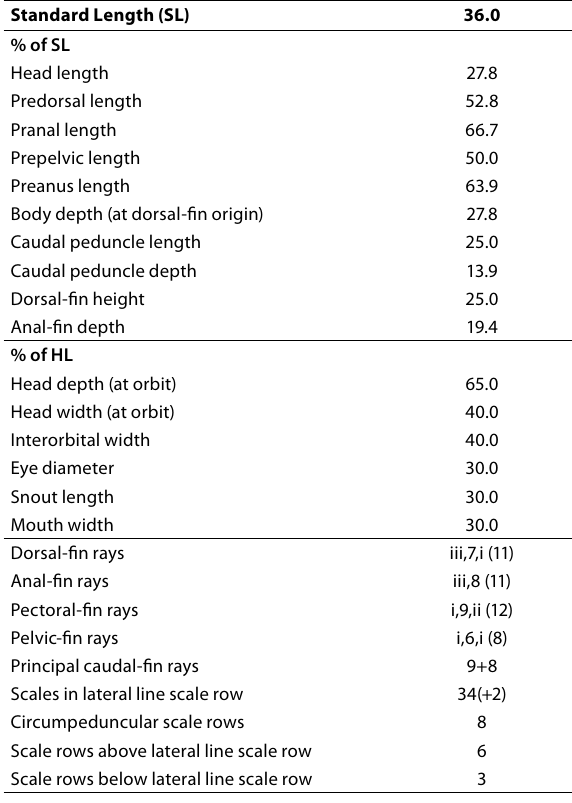
Table 1. Measurements and counts obtained from the individual of Cyprinella panarcys collected from the Rio Grande (TCWC 19724.01). The total number of rays is provided (in parentheses) for the dorsal, anal, and paired fins.